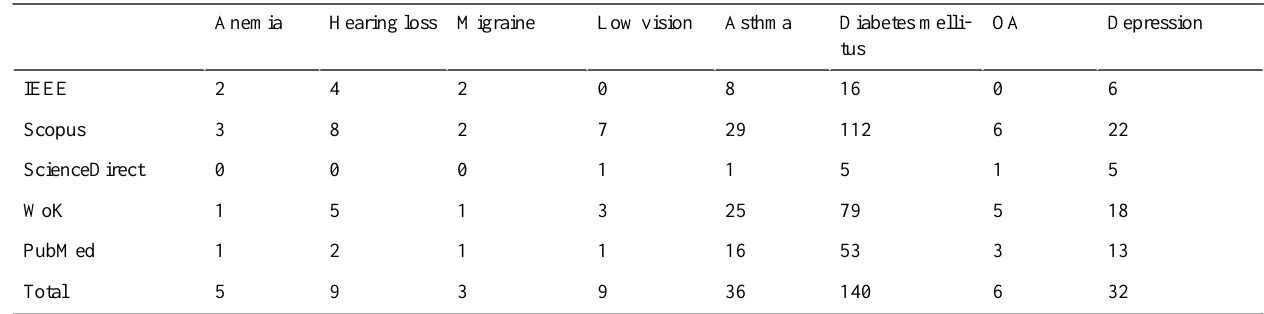
Table 1. Results of the literature review.